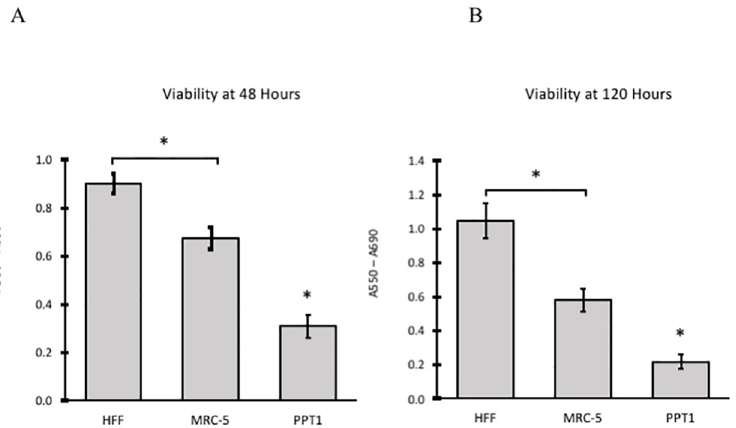
Fig 2. PPT1-deficient fibroblasts display reduced cell viability compared to controls. 1x10 4 cells from each group were plated in 5–8 wells of a 96-well plate in 1% serum DMEM, and viability was determined by MTT assay. (A) Viability was determined 48 hours post-plating. (B) The experiment was repeated with a viability measure at 120 hours post-plating. PPT-deficient cells displayed a similar reduction in relative cell viability regardless of either time points. Significant differences were found between all groups ( � , p <